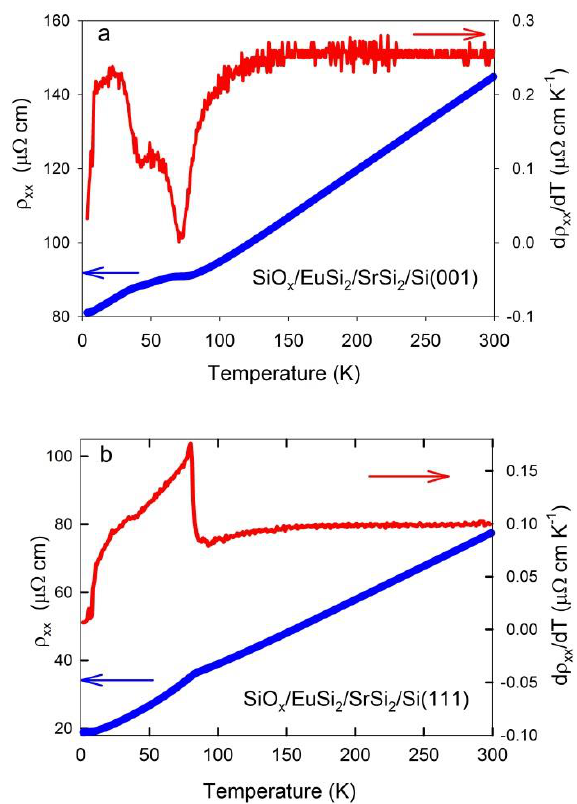
(blue) Fig. 6. Temperature dependence of resistivity (red) for thin and its temperature derivative 𝜌𝜌 𝑥𝑥𝑥𝑥 films: a) SiO x /EuSi 2 /SrSi 2 /Si(001) and b) 𝑑𝑑𝜌𝜌 𝑥𝑥𝑥𝑥 𝑑𝑑𝑑𝑑⁄ SiO x /EuSi 2 /SrSi 2